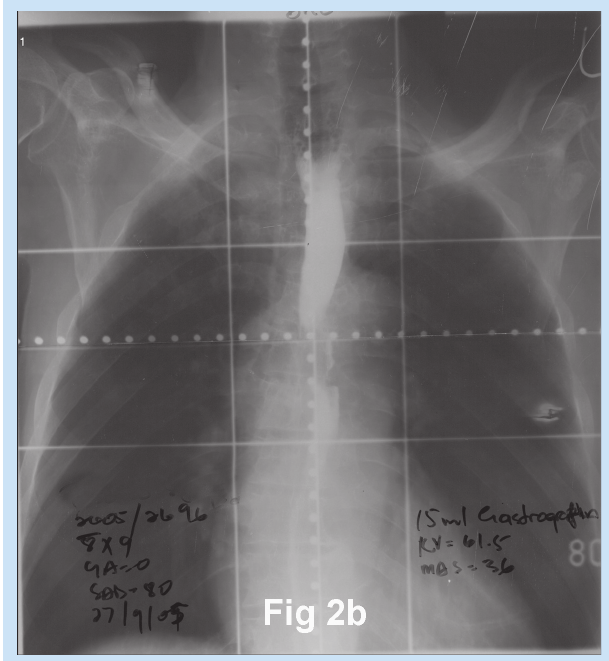
Fig. 2b. Simulator film with gastrograffin as a